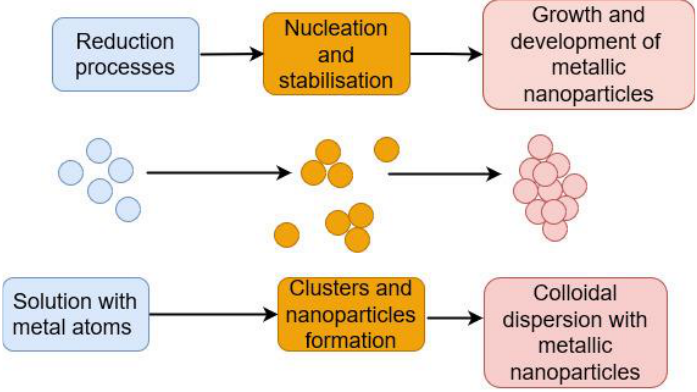
Figure 5. Classical bottom-up type of synthesis — the creation of metal NPs via chemical reduction. When NPs are formed by bottom-up synthesis, their stability in colloidal solutions depends on the surface charge. The NP charge is affected by several factors, e.g., the chem- ical composition of NPs, the type of interface, the presence of other ions in the solution, pH or the influence of external electromagnetic forces [161]. The properties of the interface between the two phases are theoretically determined by the different spatial